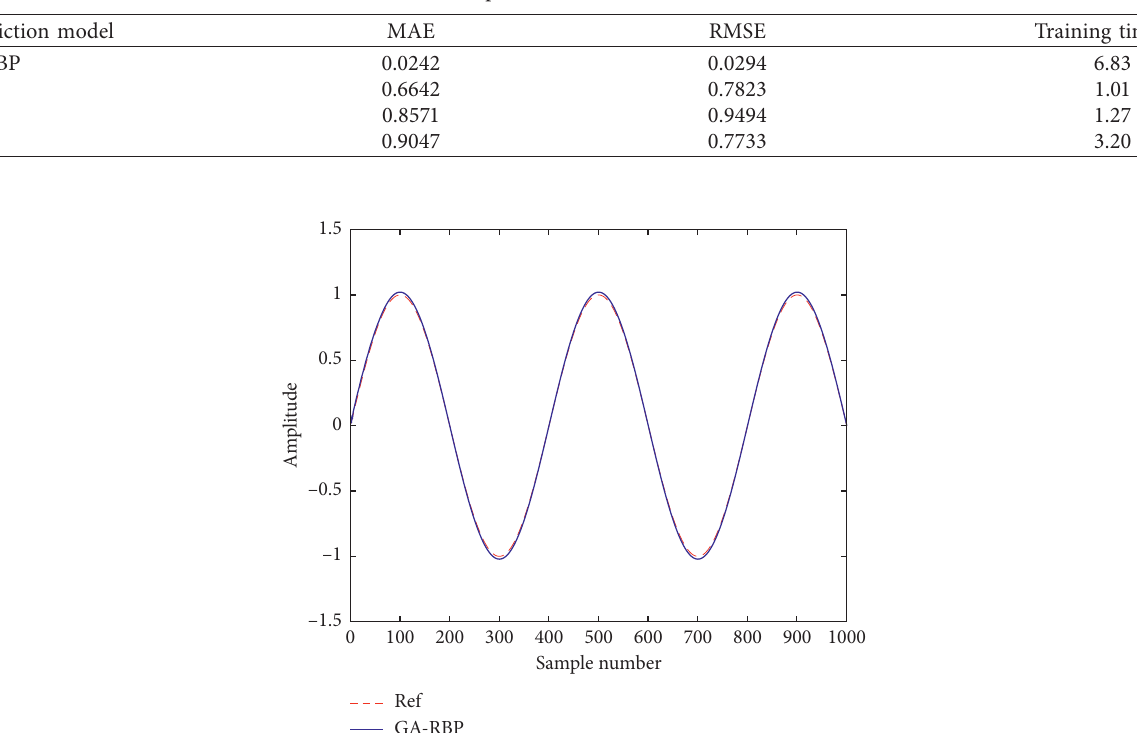
Table 2: The performance of different models.